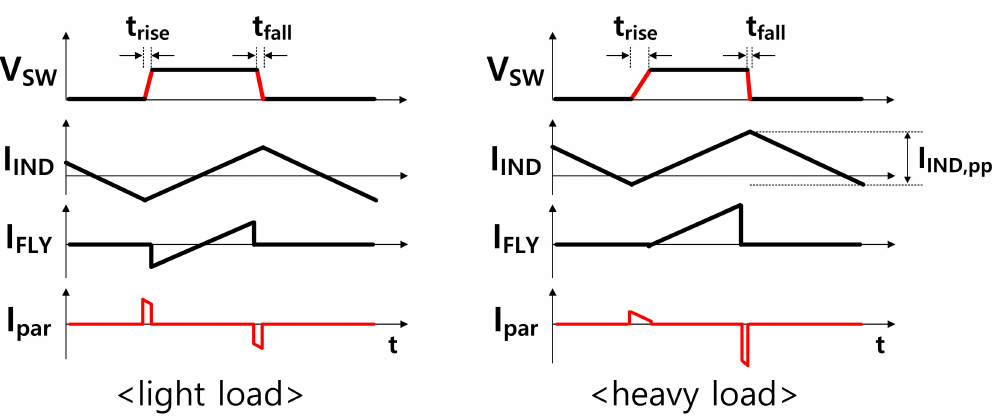
Figure 4. Waveforms and timing variation of t rise and t fall according to the load